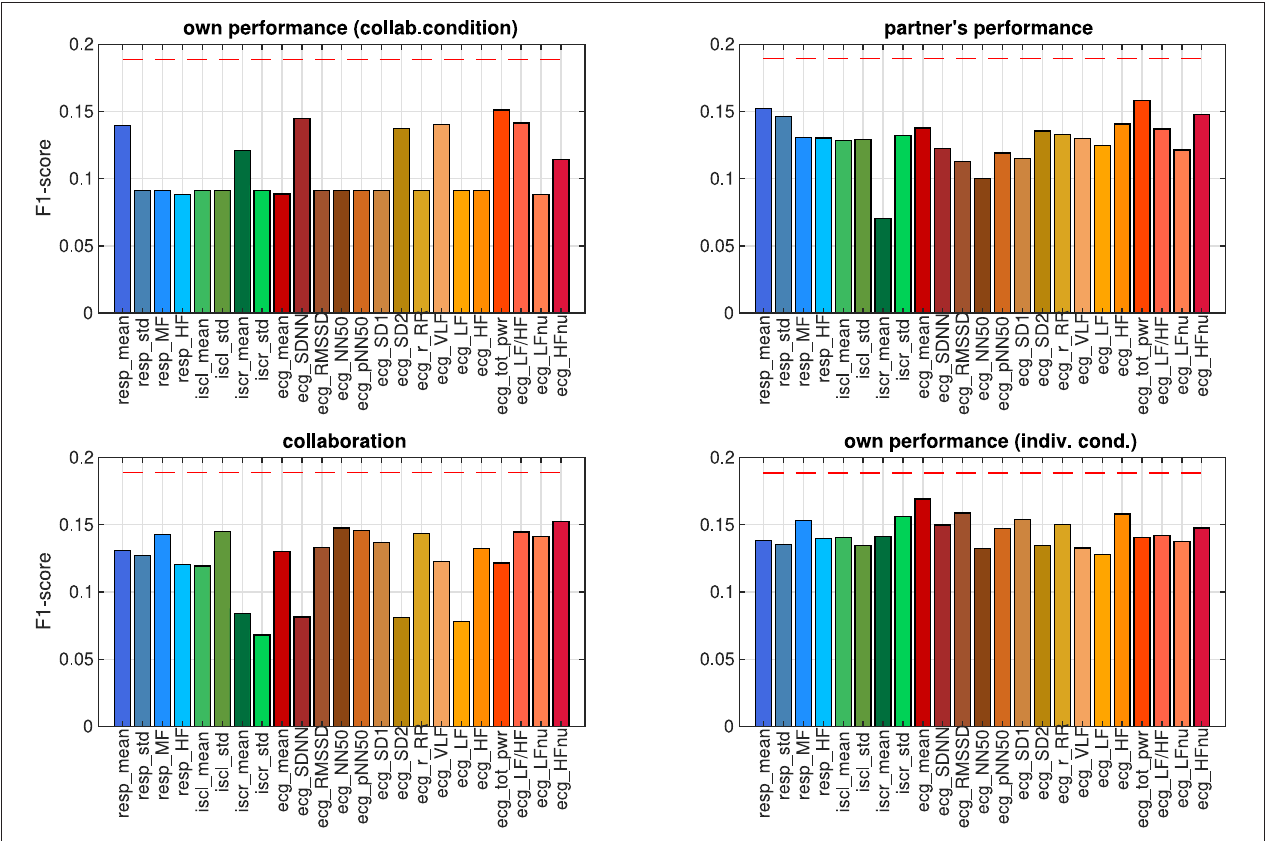
FIGURE 7 | F1-scores of predicting ratings from individual autonomic parameters, estimated using leave-one-sample-out cross-validation. Dashed red lines mark the 0.05 quantile of obtaining the corresponding F1-score or higher by chance (FDR-corrected).